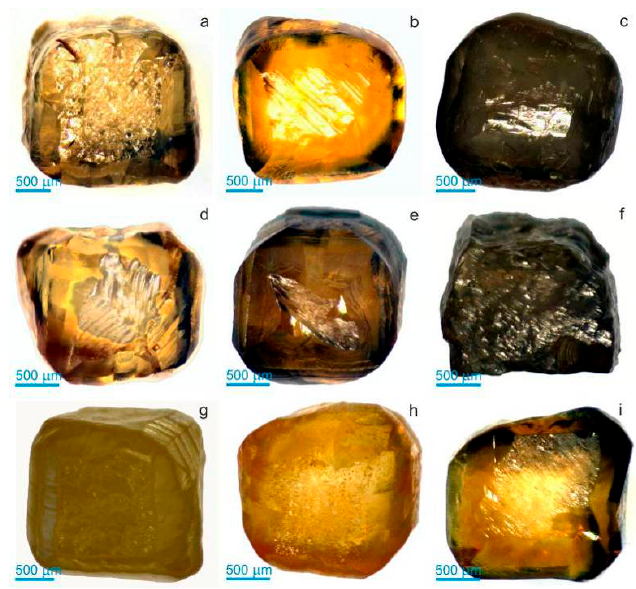
Figure 1. Optical microphotographs of cuboid diamonds from the Northeastern Siberian platform ( a —Light yellow crystal MP-30 of predominant cubic habit; b —Orange-yellow crystal MP-43 of combination form (cube-tetrahexahedroid); c —Yellowish-grey diamond rounded crystal MP-56; d —Light yellow crystal MP-30 of transition form (cube-tetrahexahedroid); e —Dark yellow crystal MP-60 of combinational form (cube-tetrahexahedroid); f —Yellowish-grey diamond crystal MP-83 of cubic habit; g —Greyish-yellow crystal MP-87 of combination form (cube-tetrahexahedroid); h —Yellow crystal MP-98 of transition form (cube-tetrahexahedroid); i —Orange-yellow crystal MP-43 of combination form (cube-tetrahexahedroid)).